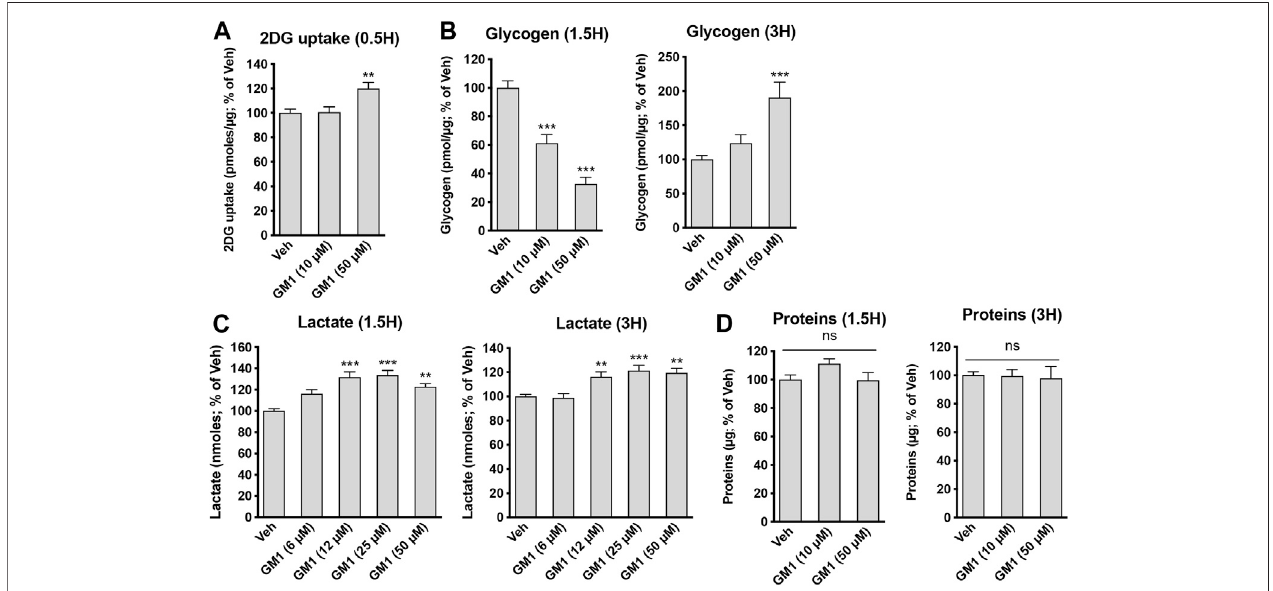
FIGURE 1 | Modulation of astrocytic glycolysis by GM1. (A) 2-deoxyglucose (2DG) uptake by astrocytes during 30 min-treatment with Veh (DMSO 0.1%) or GM1 (10and50 μ M).Dataareshownastheaverage+SEMof2DGuptake(pmoles/ μ g)expressedas%ofVeh( n (cid:2) 20). (B) Intracellularlevelsofglycogeninprimaryastrocytes after1.5-and3 htreatmentwithVeh(DMSO0.1%)orGM1(10and50 μ M).Dataareshownastheaverage+SEMofglycogenlevels(pmoles/ μ g)expressedas%ofVeh ( n (cid:2) 9 – 12). (C) Extracellular secretion ofL-lactate from astrocytes after treatment with Veh (DMSO 0.1%) or GM1 (6 – 50 μ M) for 1.5 and 3 h. Data are shown as the average +SEM of extracellular L-lactate (pmoles) expressed as % of Veh ( n > 40). (D) Total protein in primary astrocytes during 1.5-and 3 h treatment with Veh (DMSO 0.1%) or GM1 (10 and 50 μ M). Data are shown as the average +SEM of protein levels (pmoles/ μ g) expressed as % of Veh ( n (cid:2) 9 – 12). Statistical analyses consisted in one-way ANOVA followed by Dunnett ’ s post-hoc test; * p < 0.05, ** p < 0.01, *** p <